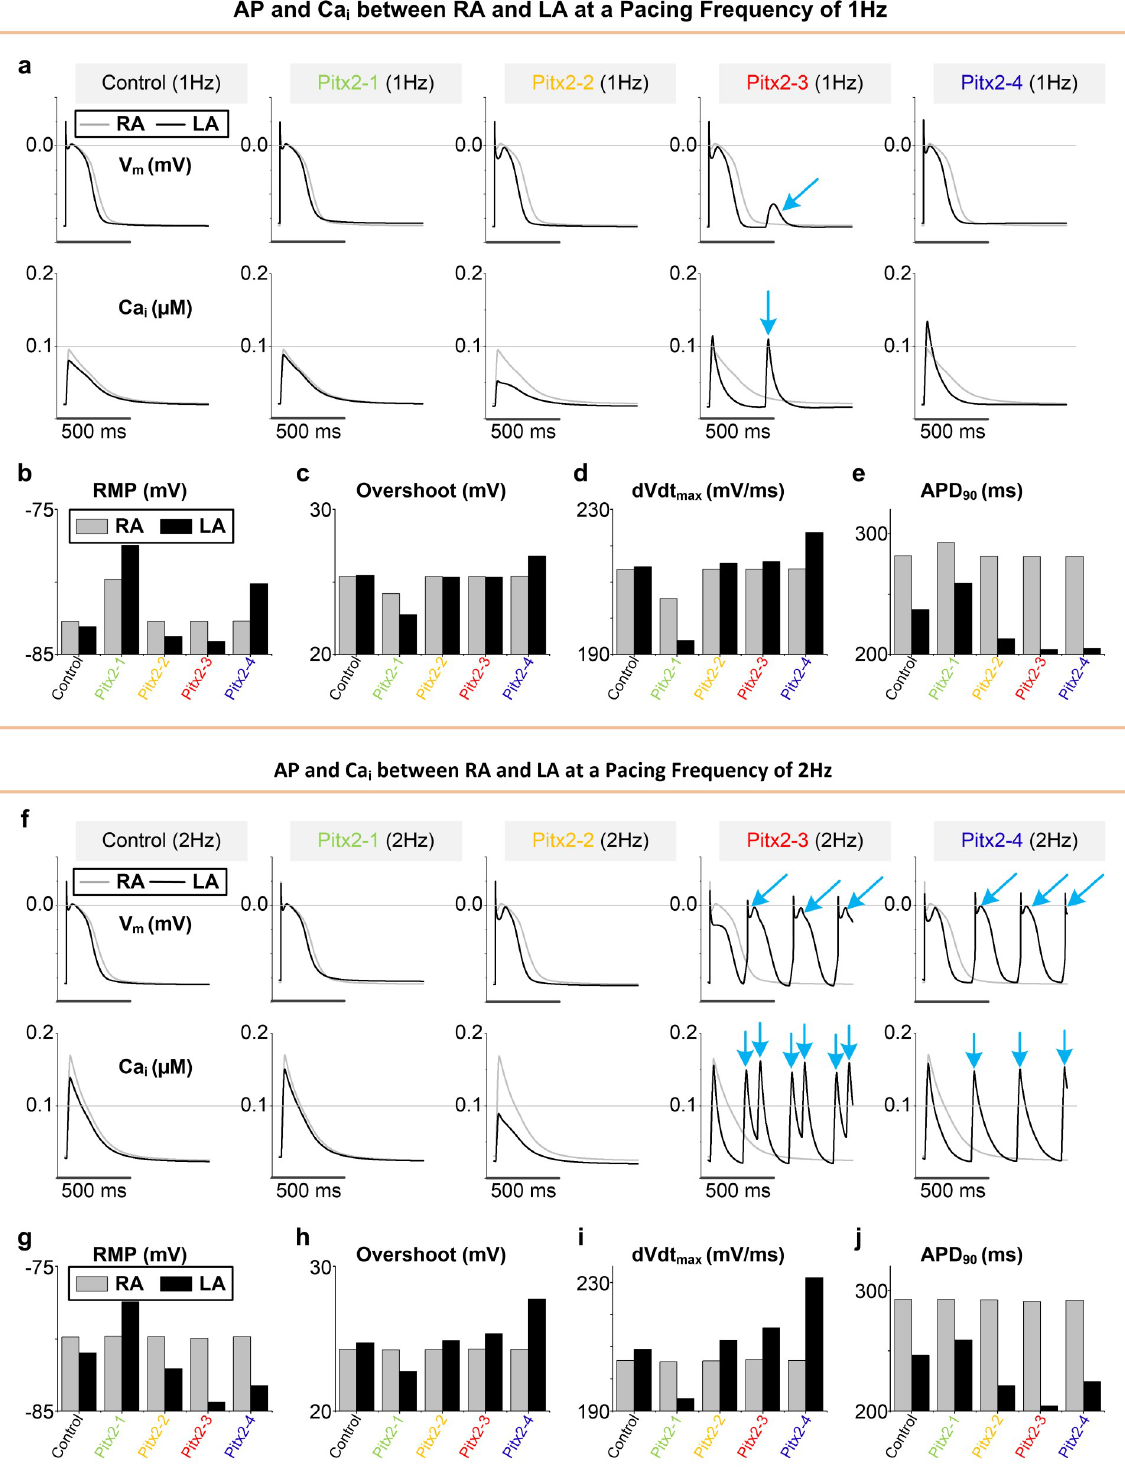
Fig 2. Simulated action potentials (AP, V m ) and calcium transients (Ca i ) of left atrial (LA) and right atrial (RA) cells under controls and Pitx2-induced remodelling conditions. At a pacing frequency of 1Hz, AP and Ca i ( a ), RMP ( b ), overshoot ( c ), dVdt max (d ) and APD ( e ) under control, Pitx2-1, Pitx2-2, Pitx2-3 and Pitx2-4 conditions. Black and grey markers were used for LA and RA cells, respectively. Similar